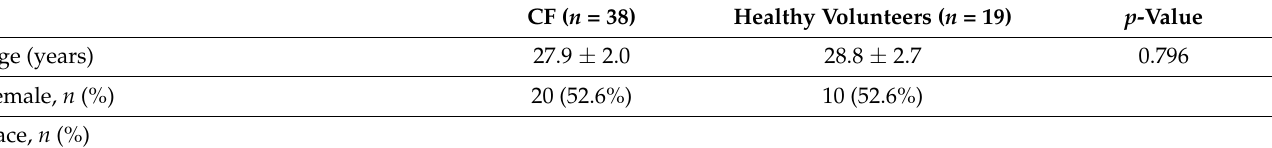
Table 3. Correlation analyses and multiple linear regression of FEV1 vs body composition measures in participants with CF.